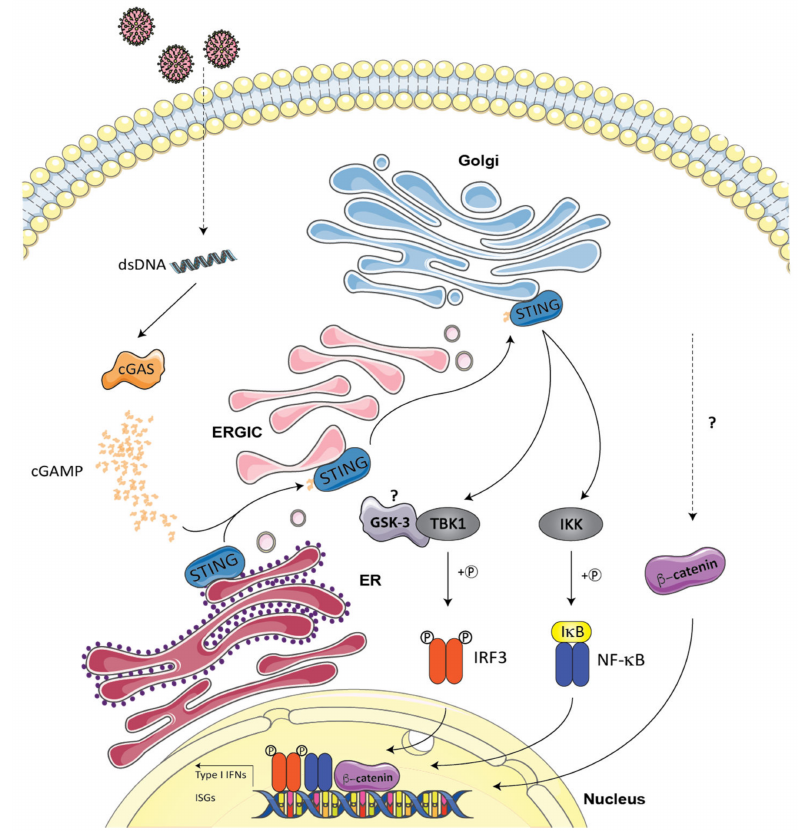
Figure 4. GSK-3 / β -catenin in sensing of cytosolic DNA by the cyclic GMP–AMP synthase (cGAS) / STING pathway. Upon infection by DNA viruses, several DNA sensors molecules show overlapping abilities in their capacity to induce a type I IFN antiviral response, but cGAS is the most characterized. Upon binding with DNA molecules, it rapidly produces a second messenger cyclic GMP-AMP (cGAMP) that activates the endoplasmic reticulum (ER)–resident adaptor protein STING. In a complex with cGAMP, STING translocates from the ER to the ERGIC / Golgi to activate TBK1-IRF3 and NF- κ B, resulting in robust type I IFN induction and inflammatory cytokine production. Limited information is available on the cross talk between the GSK-3 / β -catenin and cGas / STING pathways. It may happen through either the recruitment of GSK-3 to TBK1 or through the binding of p- β -catenin Ser552 with the IRF3 promoter in association with TCF4 for the induction of type I IFN. The model was created using Servier Medical Art templates (www.servier.com) licensed under a CC BY 3.0 license (https: // creativecommons.org / licenses / by / 3.0 /